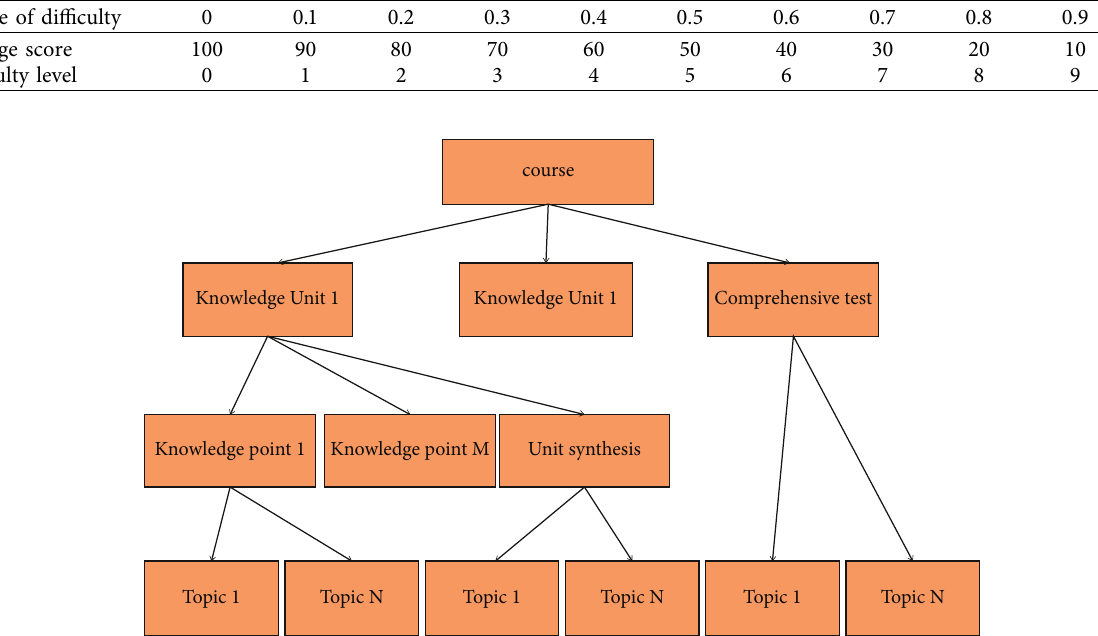
Figure 2: Data modeling of the question bank based on the knowledge tree